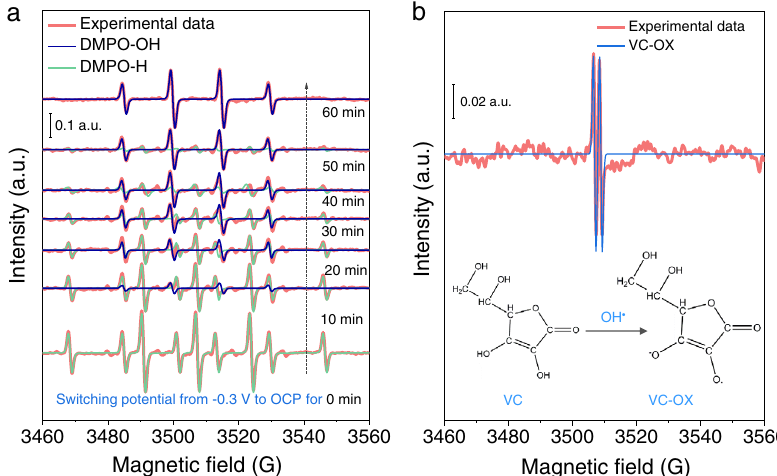
Fig. 2 EPR spectra were recorded in a CO 2 -saturated 0.5 M KHCO 3 electrolyte containing 100 mM DMPO. a Time-dependent EPR spectra of the KHCO 3 solution after switching potential from − 0.3 V RHE (20 min reduction) to OCP for different periods. b EPR spectra of the KHCO 3 solution with 10 mM VC. Inset shows the structure transition from VC and oxidized VC-OX caused by OH (cid:129) . The simulated EPR spectra of DMPO-OH, DMPO-H, and VC-OX adducts were obtained according to their hyper fi ne splitting